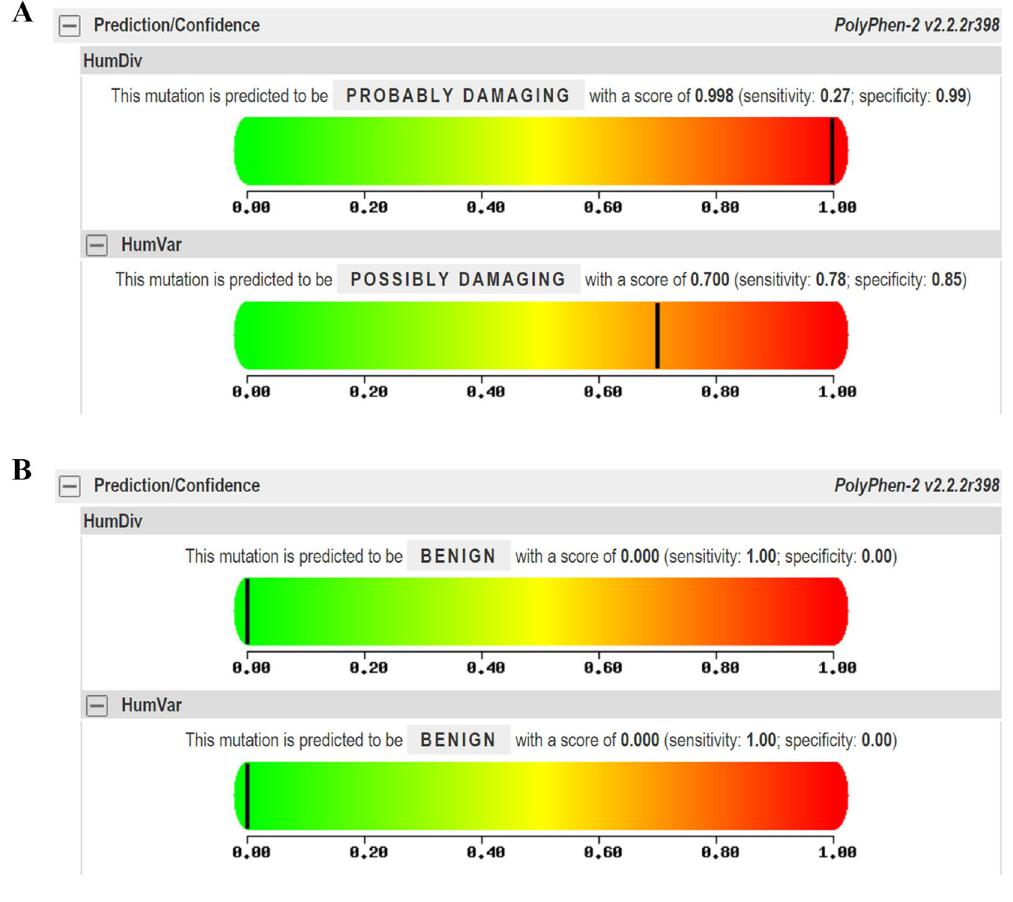
Figure 4. The relationship between G388R, V10I polymorphisms and FGFR4 protein damaging analyzed by Polyphen2 tools (black lines represent scores).